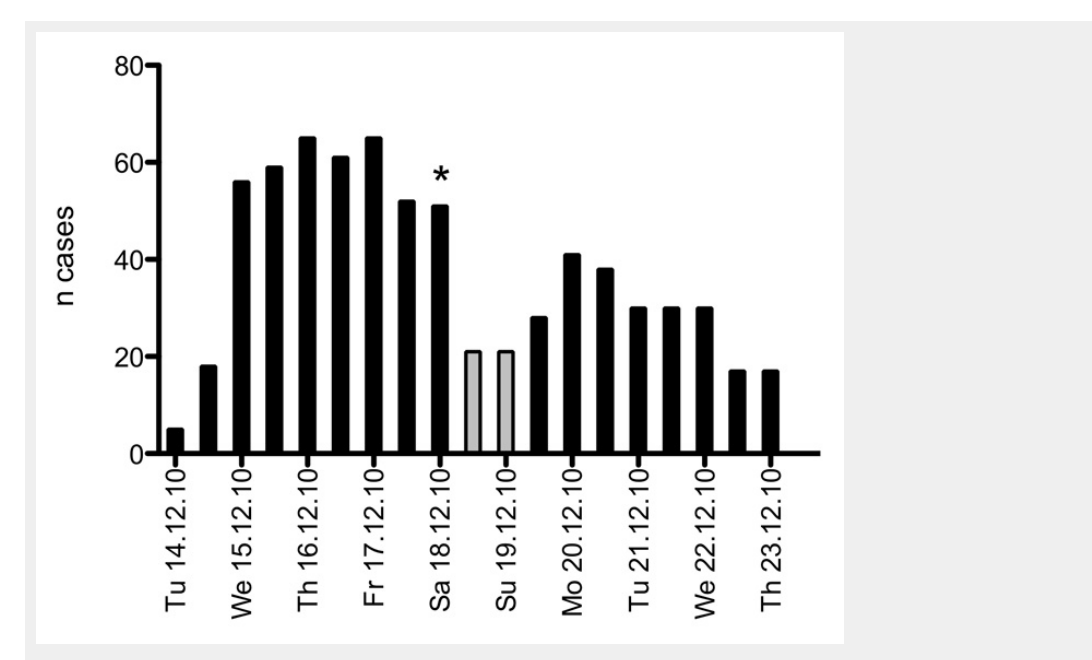
Epidemic curve, representing all cases at infirmary every 12 hours. The 32 patients, who stayed at home after the weekend break, were not included because the exact day of disease onset was not known. The gray bars indicate a 36 hour weekend-leave for healthy recruits. * = hospitalisation of two